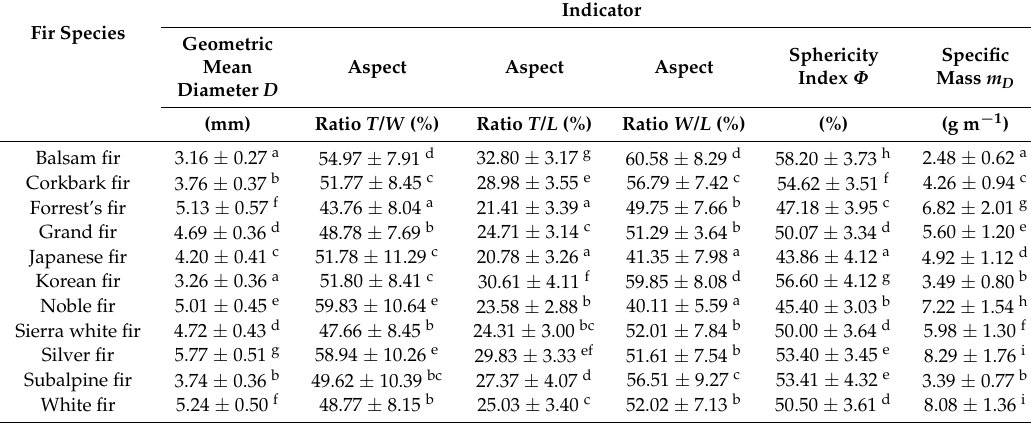
Table 2. Mean values ( ± standard deviation) of the calculated indicators of seeds of selected fir species. Superscript letters denote significant differences between properties at p < 0.05 (Duncan’s